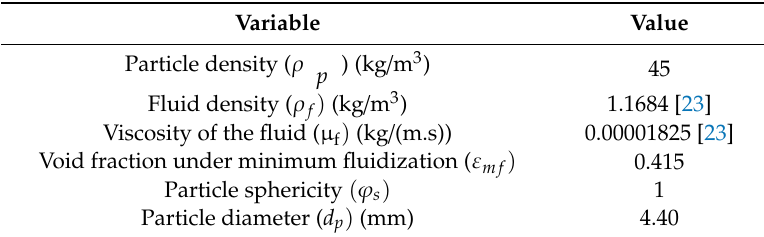
Table 3. Parameters of Ergun